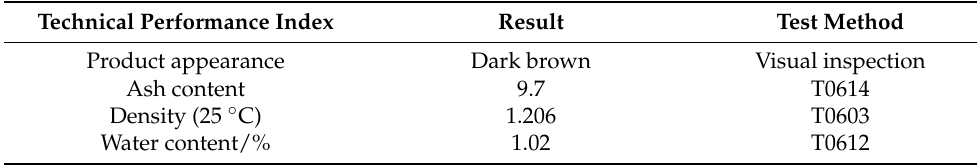
Table 2. Technical performance of Qingchuan rock asphalt.